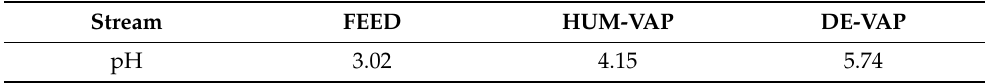
Table 5. pH stimulation